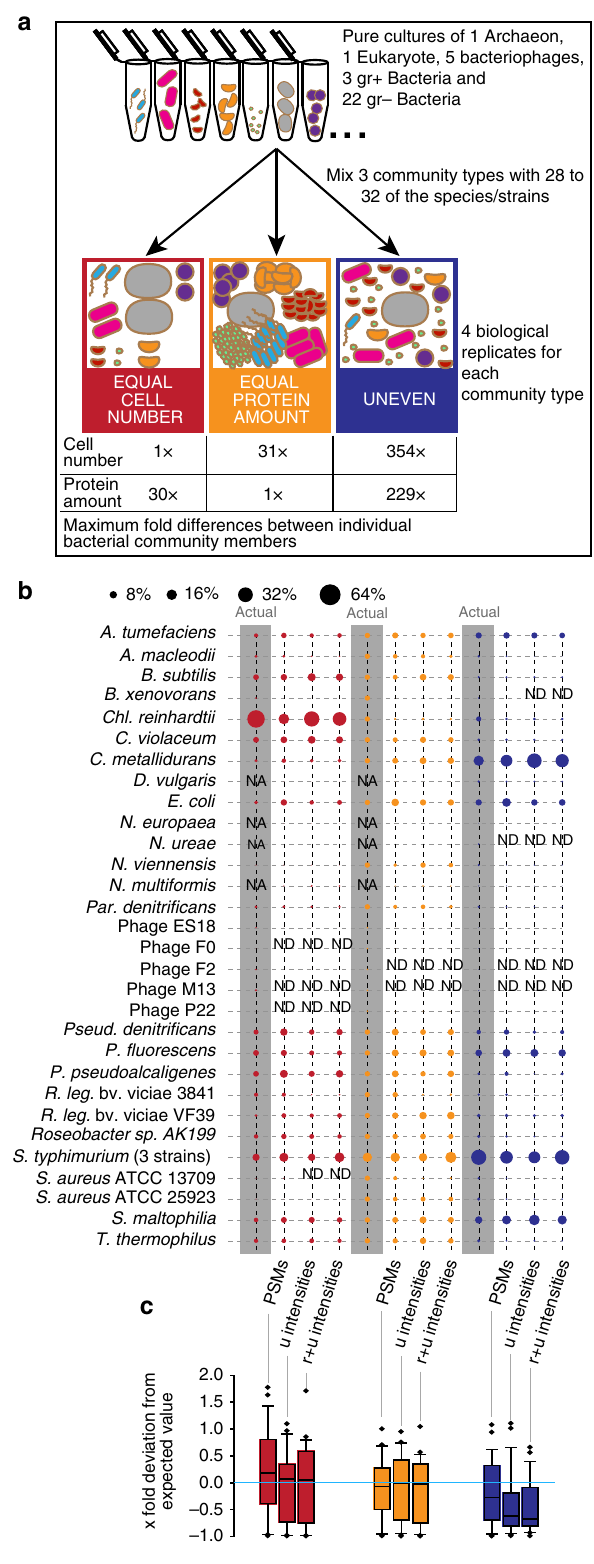
Fig. 3 Quanti fi cation of mock community using three proteomic quanti fi cation methods. a Illustration of mock community construction. 32 species and strains were used for the construction of three distinct community types. b Comparison of three proteomic quanti fi cation